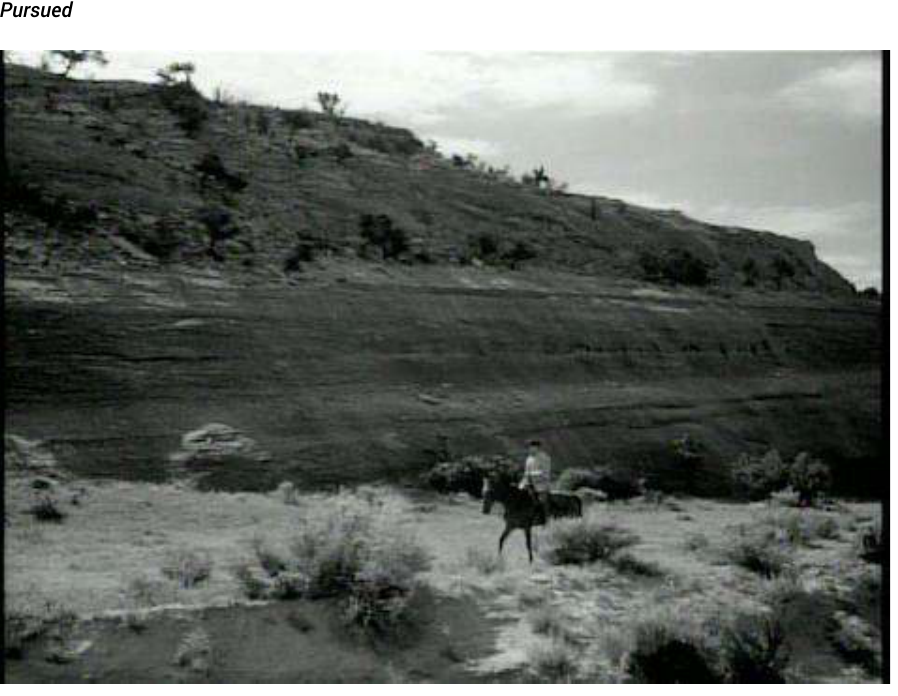
Credits: all fi gures are DVD screen